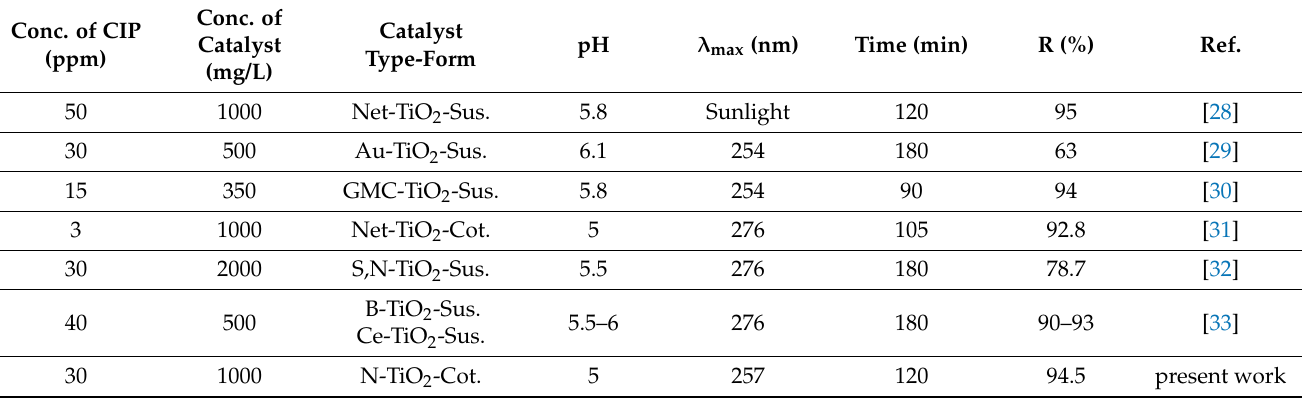
Table 1. Comparison of the operating conditions and the percentages of CIP removal for the current work and various previous